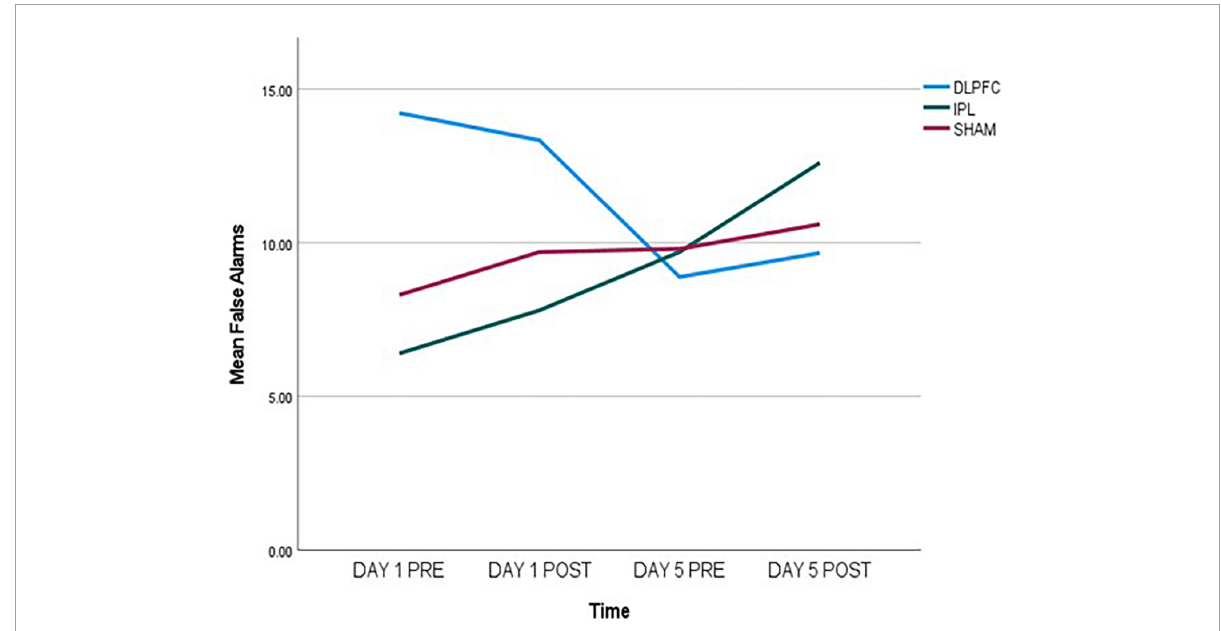
FIGURE1 False alarms (FA) data, measured pre- and post-stimulation on day 1 and day 5, indicating a decrease in the DLPFC-group, an increase in the IPL-group, and almost no change in the